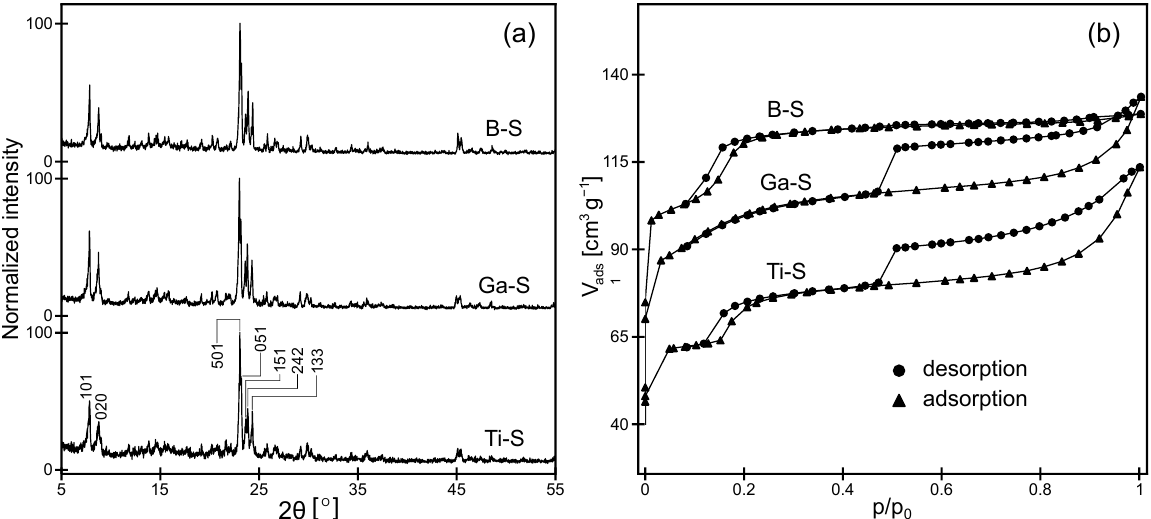
Figure 2. ( a ) X-ray diffractograms of the as synthesized B-, Ga- and Ti- silicalite samples; ( b ) nitrogen adsorption and desorption isotherms of the B-, Ga- and Ti- silicalite samples in the H +